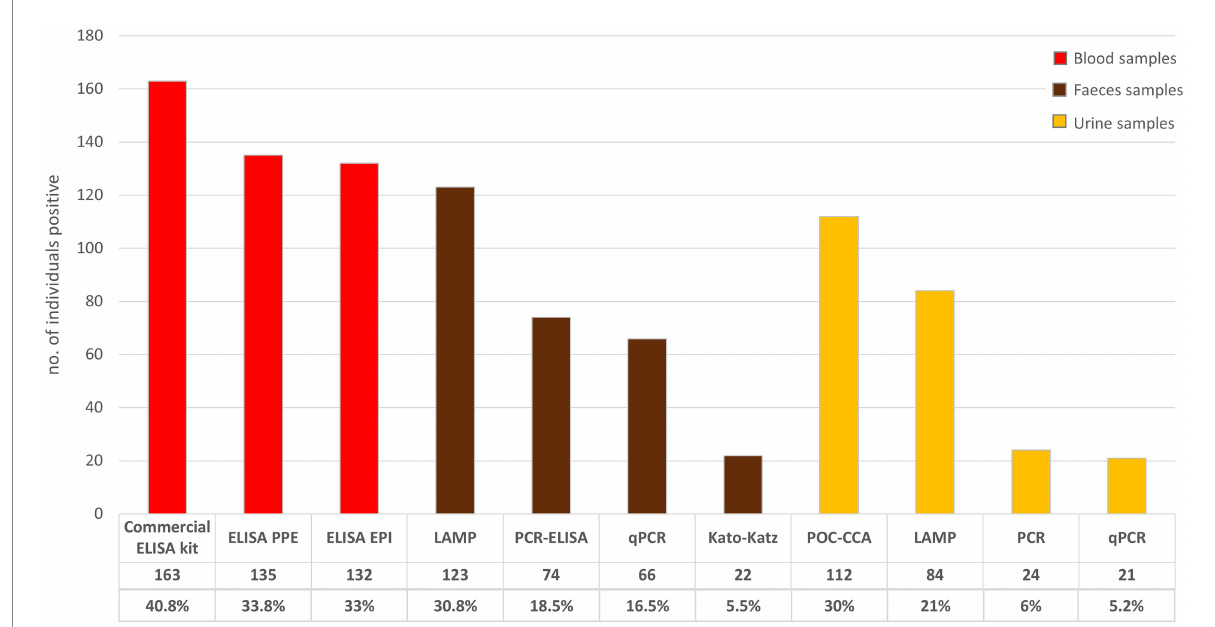
FIGURE 2 Detection of schistosomiasis infection according to different diagnostic tests and sample types. POC-CCA positive results include trace outcome and serologically negative results include indeterminate